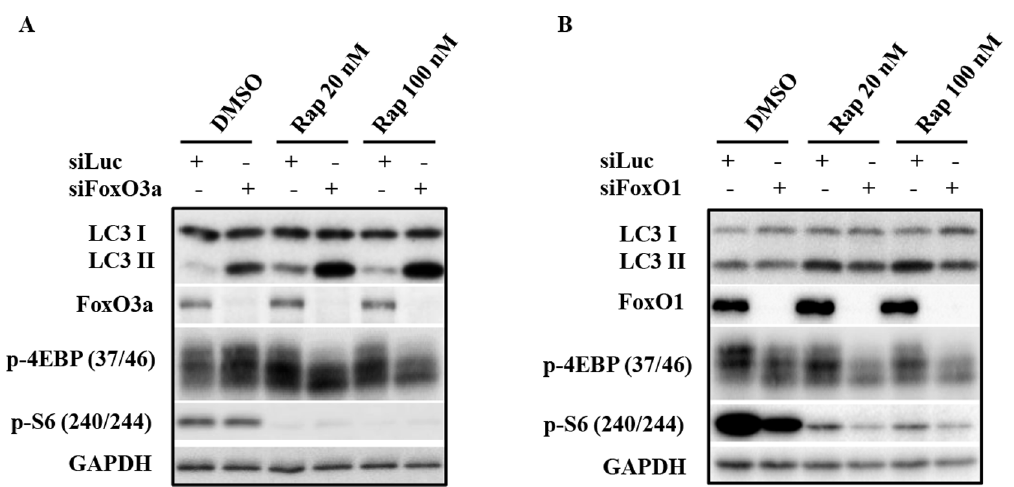
Fig. 6. FoxO3a and FoxO1 regulation of autophagy is unlikely to be dependent on mTORC1 activity. (A) PC3 cells were transfected with siRNAs targeting FoxO3a as indicated. Following 48 h of transfection, cells were subjected to rapamycin treatment for 24 h prior to processing for immunoblot analysis of the indicated proteins. (B) PC3 cells underwent similar study as described in (A), except siRNA targeting FoxO1 was used as indicated. All experiments have been performed three times with similar